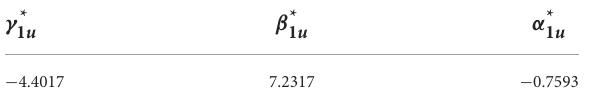
TABLE 5 Parameters estimates of the time-varying model for the upper-tail-dependence coefficients λ * U 1 m .